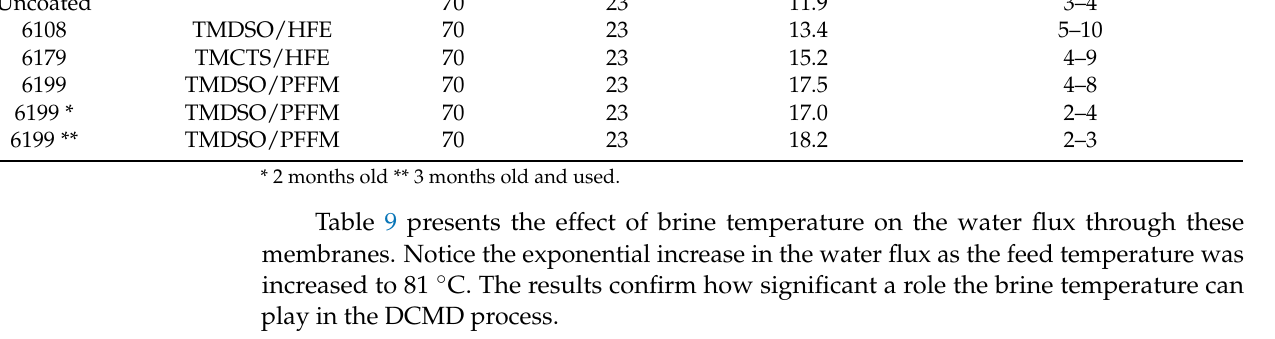
Table 9. Effect of brine water temperature on water flux for a brine concentration of 8% w / v . Sample No.